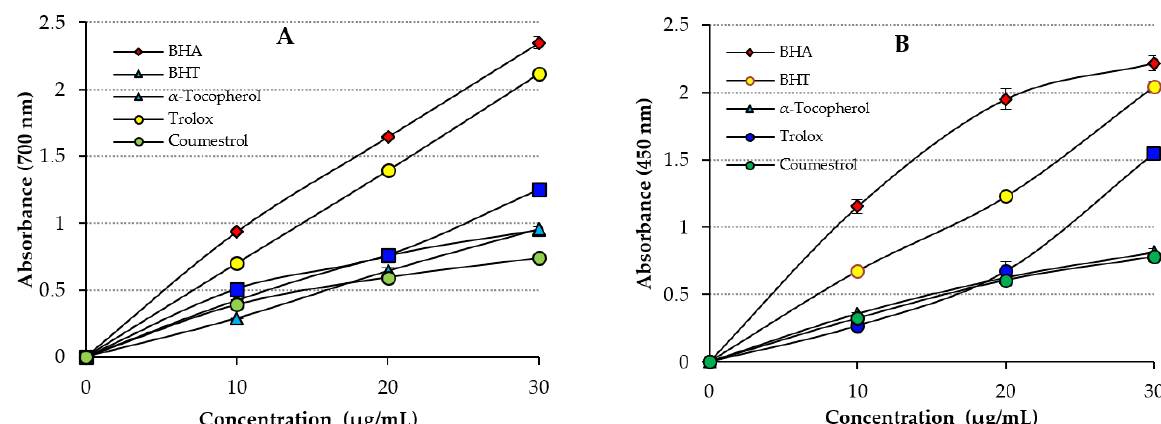
Figure 3. ( A ) Fe 3+ -reducing activity of Coumestrol and of standards; ( B ) Cu 2+ -reducing activity of Coumestrol and of standards.